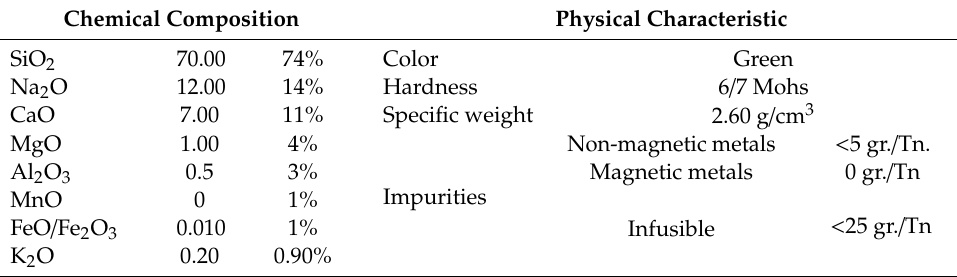
Table 3. Glass recycled properties according to Camacho Recycling S.L.